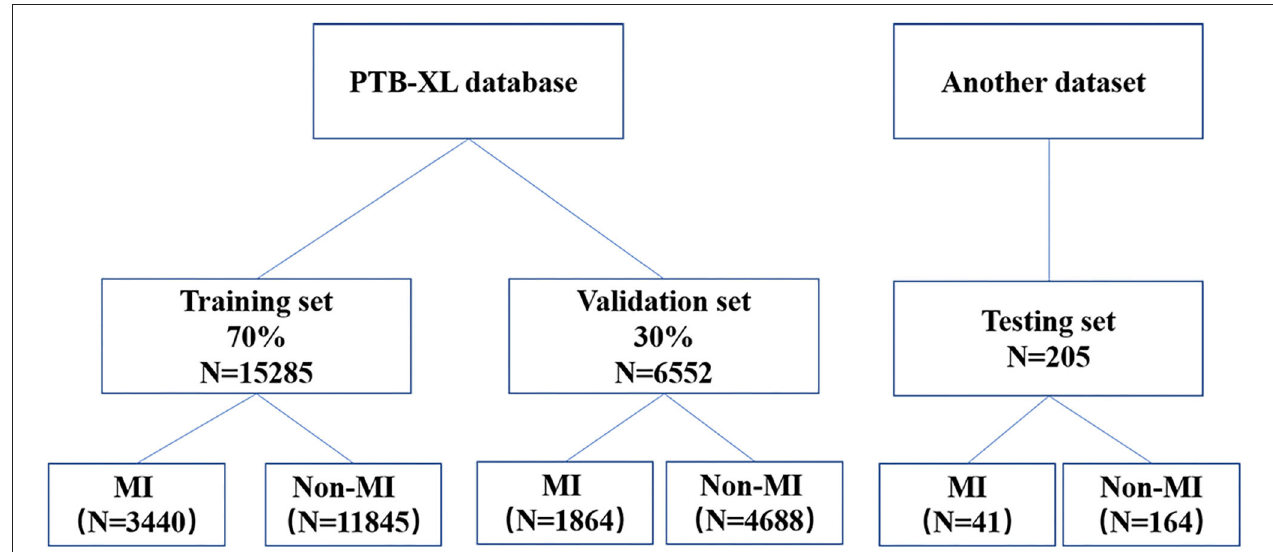
FIGURE 1 | A flow diagram indicating the selection of electrocardiography for the training, validation, and testing.